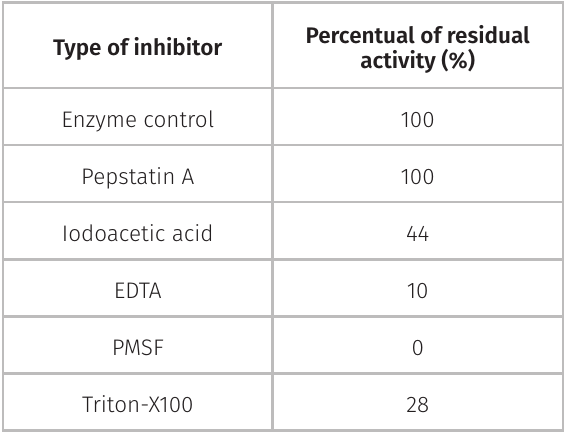
Table II. Effect of specific protease inhibitors on catalytic activity of purified enzyme.